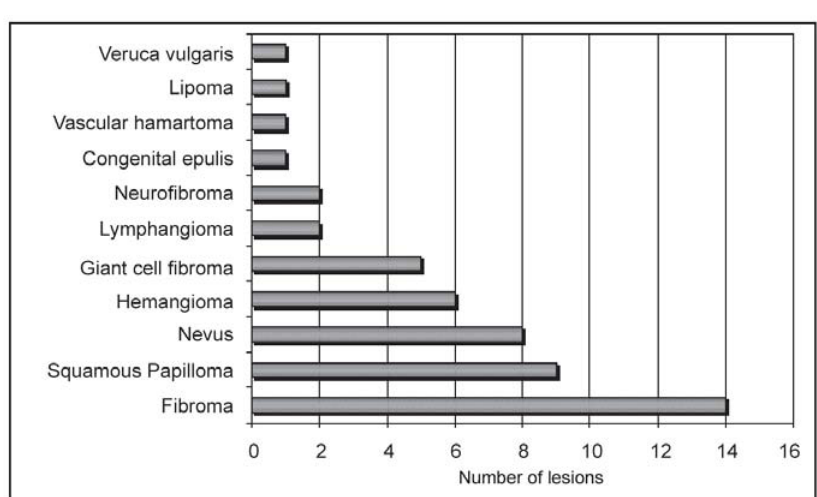
FIGURE 4- Distribution of lesions classified as benign